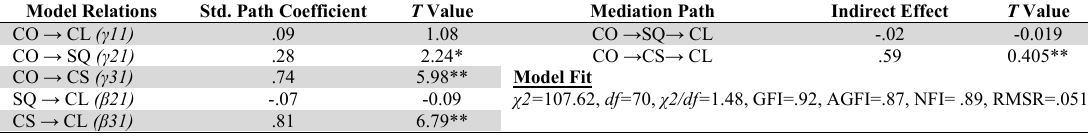
Structural Standardized Path Coef fi cients for Proposed Model Model